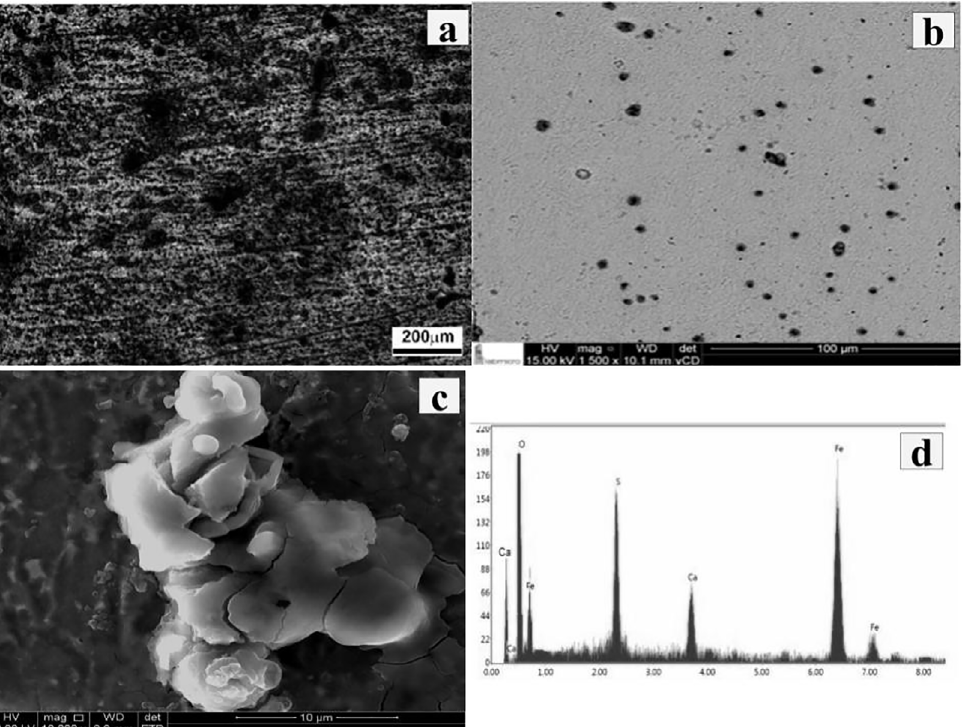
Figure 13. OM (a) and SEM (b) images of the API 5L X80 steel after 24h immersion in deaerated solution A, NACE TM0284 (2011), saturated with